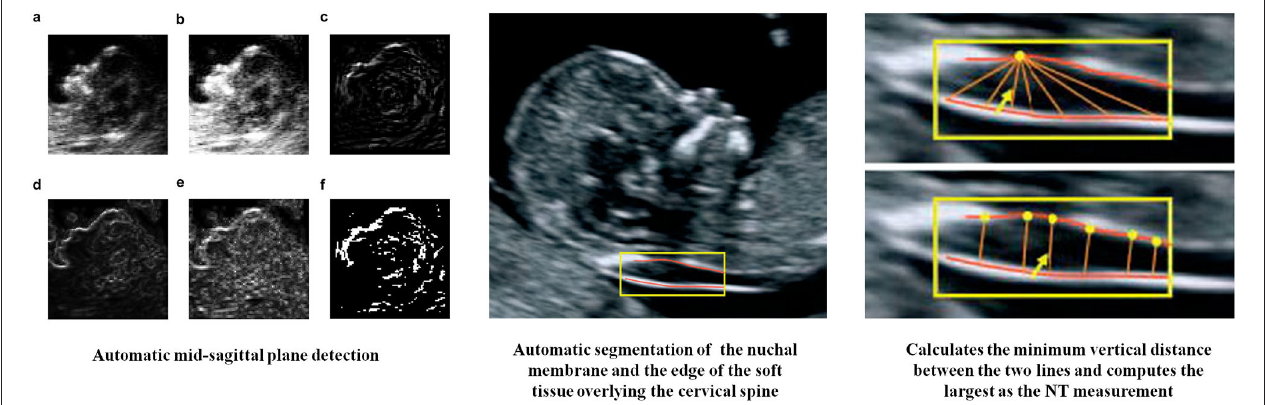
FIGURE 1 | AI in measurement of NT thickness (12, 13). (a) Original image, (b) after histogram equalization, (c–e) detection results of different methods (directional edge image, SRAD edge image, and KAD edge image), (f) binary the direction edge image.